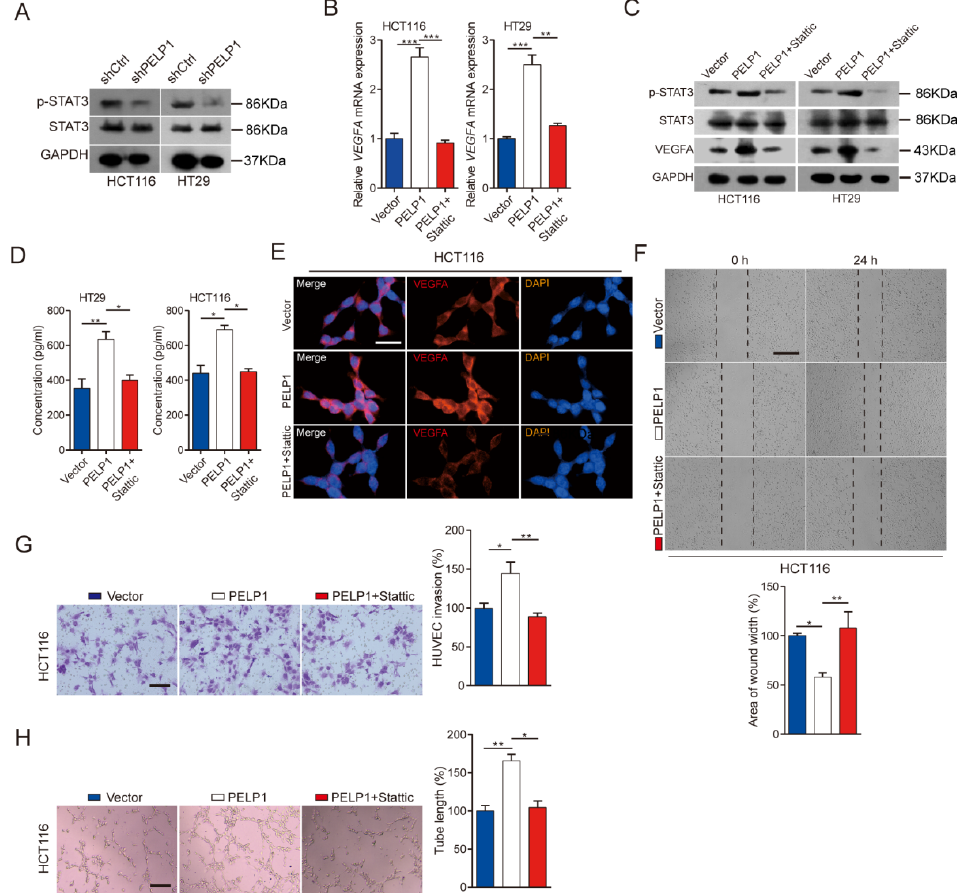
Figure 4. PELP1 promotes VEGFA-mediated angiogenesis via the STAT3: ( A ) Immunoblot analysis of p-STAT3 and STAT3 expressions in shCtrl cells or shPELP1 cells. GAPDH was used as an internal control. ( B ) RT-qPCR analysis of VEGFA in PELP1 overexpressed cells treated with or without Stattic. GAPDH was used as an internal control. ( C ) Immunoblot analysis of p-STAT3, STAT3, and VEGFA expressions in PELP1 overexpressed cells treated with or without Stattic. ( D ) ELISA analysis of VEGFA expression in PELP1 overexpressed cells treated with or without Stattic. ( E ) Representative images of immunofluorescence for VEGFA in HCT116-PELP1 CRC cells treated with or without Stattic. Scale bar: 30 µm. ( F ) Representative images of wound healing in HUVECs treated with CM from HCT116-PELP1 CRC cells treated with or without Stattic (upper panel). Scale bar: 200 µm. Histograms with the fold change in wound closure formed by the indicated cells (lower panel). ( G ) Representative images of cell invasion in HUVECs treated with CM from HCT116-PELP1 CRC cells treated with or without Stattic (left panel). Scale bar: 200 µm. Histograms with the fold change in the number of invaded cells formed by the indicated cells (right panel). ( H ) Representative images of tube formation in HUVECs treated with CM from HCT116-PELP1 CRC cells treated with or without Stattic (left panel). Scale bar: 200 µm. Histograms with the fold change in the length of tube-like formation formed by the indicated cells (right panel). Data are shown as the means of three independent experiments or representative data. Error bars indicate SD.* p < 0.05, ** p < 0.01, *** p < 0.001 by Student’s t -test.